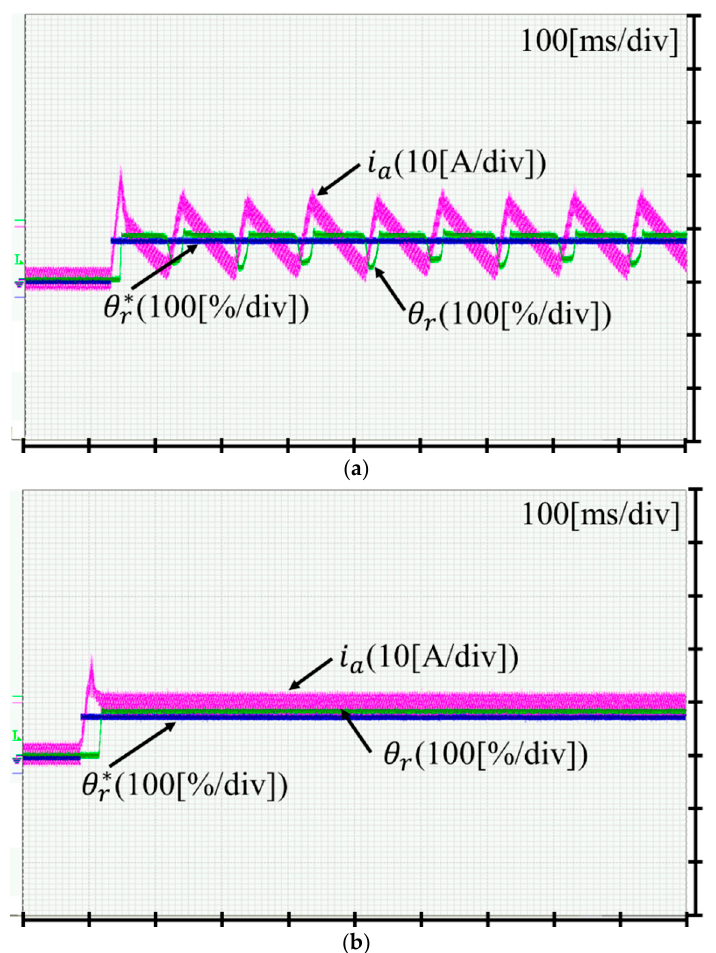
Figure 10. Comparison of the results between ( a ) conventional and ( b ) proposed position control (80% reference).